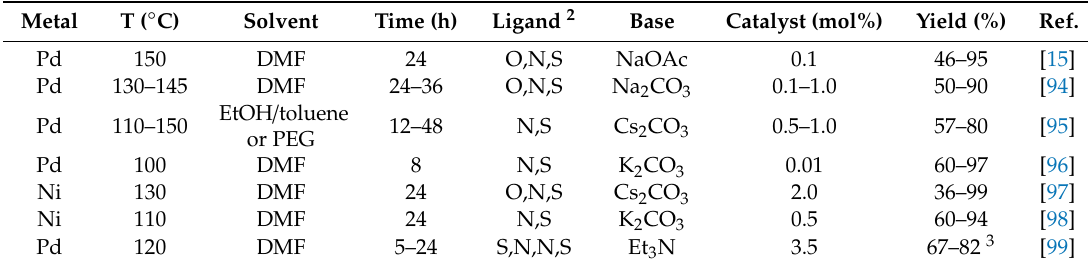
Table 1. Mizoroki–Heck reactions catalysed by thiosemicarbazone complexes: representative conditions and yields 1